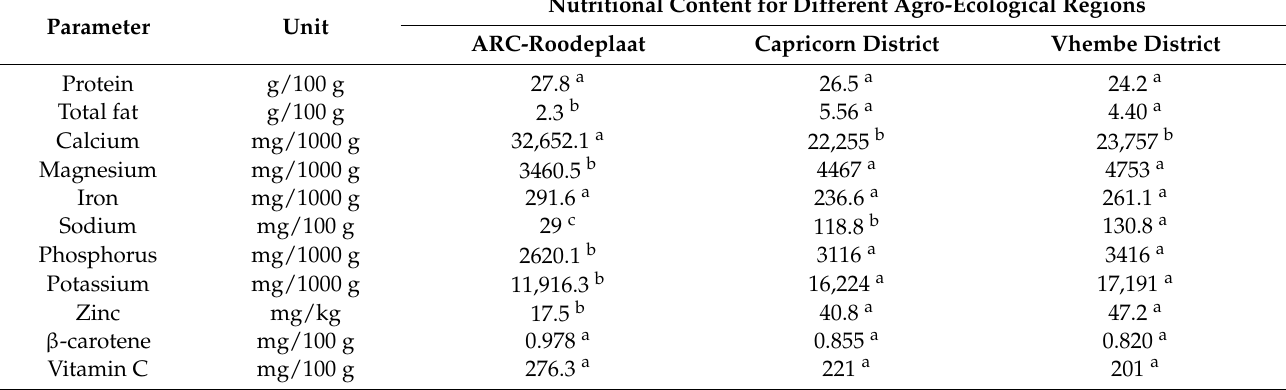
Table 4. Nutritional composition of Moringa oleifera leaves from ARC-Roodeplaat, Capricorn, and Vhembe Districts in South